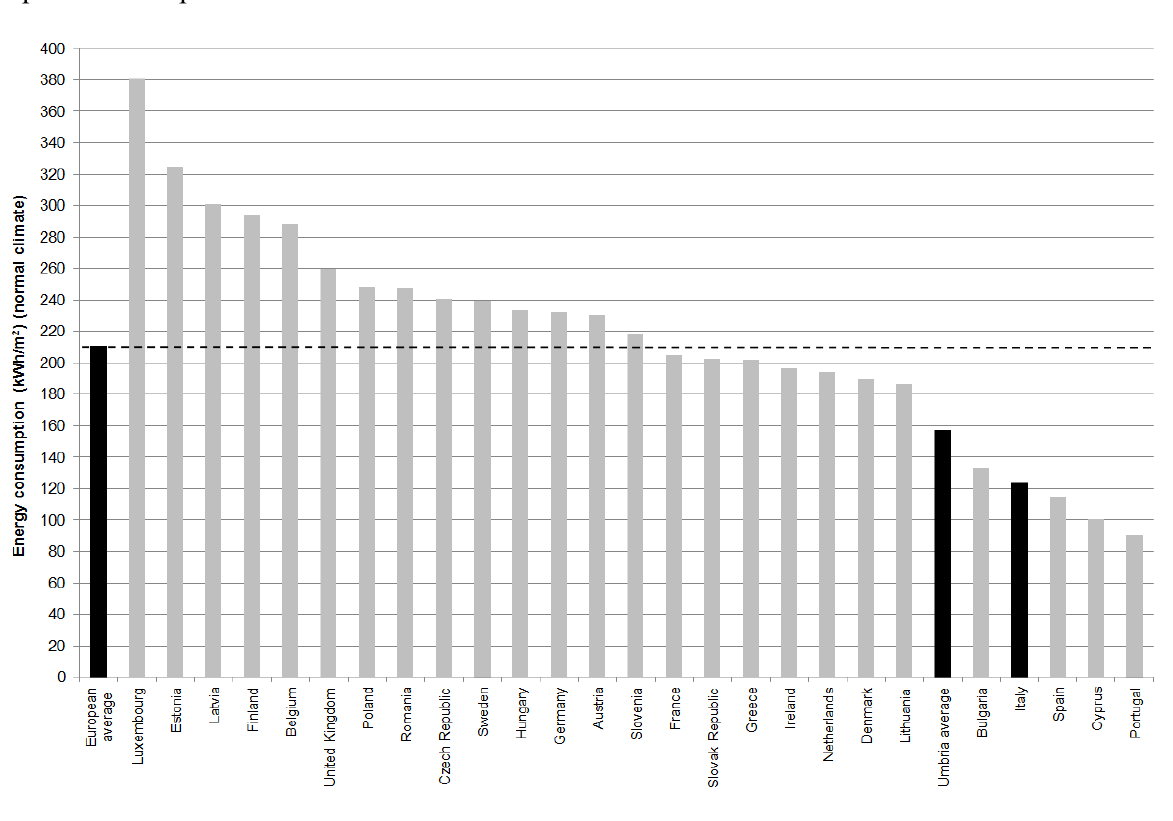
Figure 4. Comparison of the energy performance of Umbrian buildings with the one of European countries and with the mean value for European